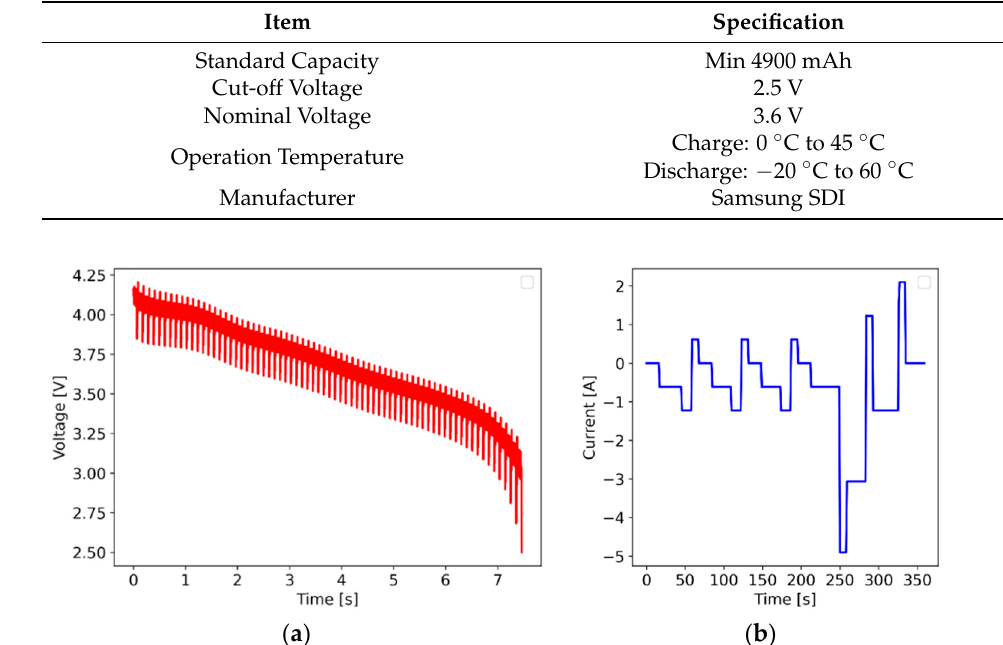
Figure 6. DST operating profile: ( a ) measured voltage and ( b ) current in one cycle (360 s). Table 2. Specification of Samsung SDI INR 21700-50E.